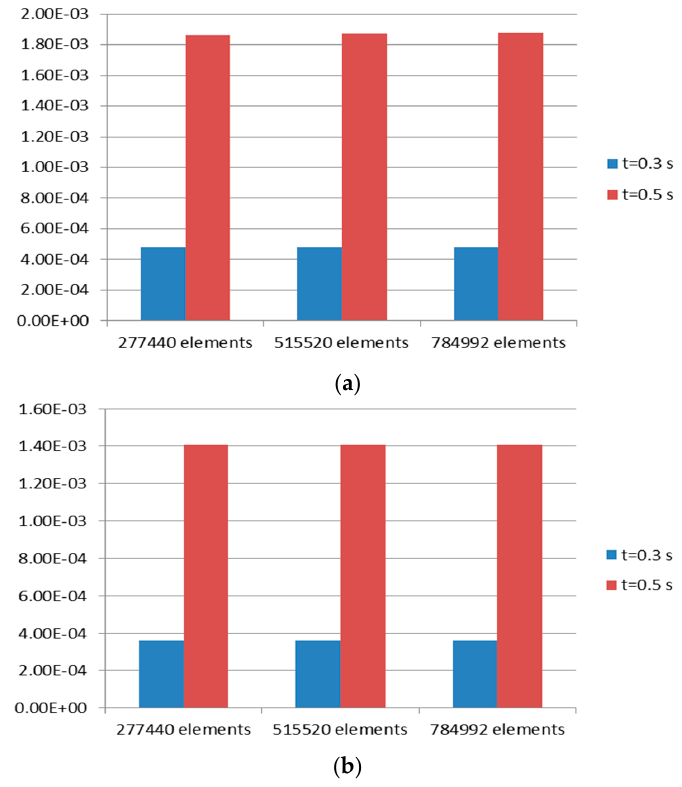
Figure 6. Mesh convergence test for tissue domain. Von Mises strain at two time values, t , was taken as criteria. ( a ) Maximum strain; ( b ) minimum strain. Table 2. Difference of maximum Von Mises strain between solution of Case 3 and two other cases ( t is time value).